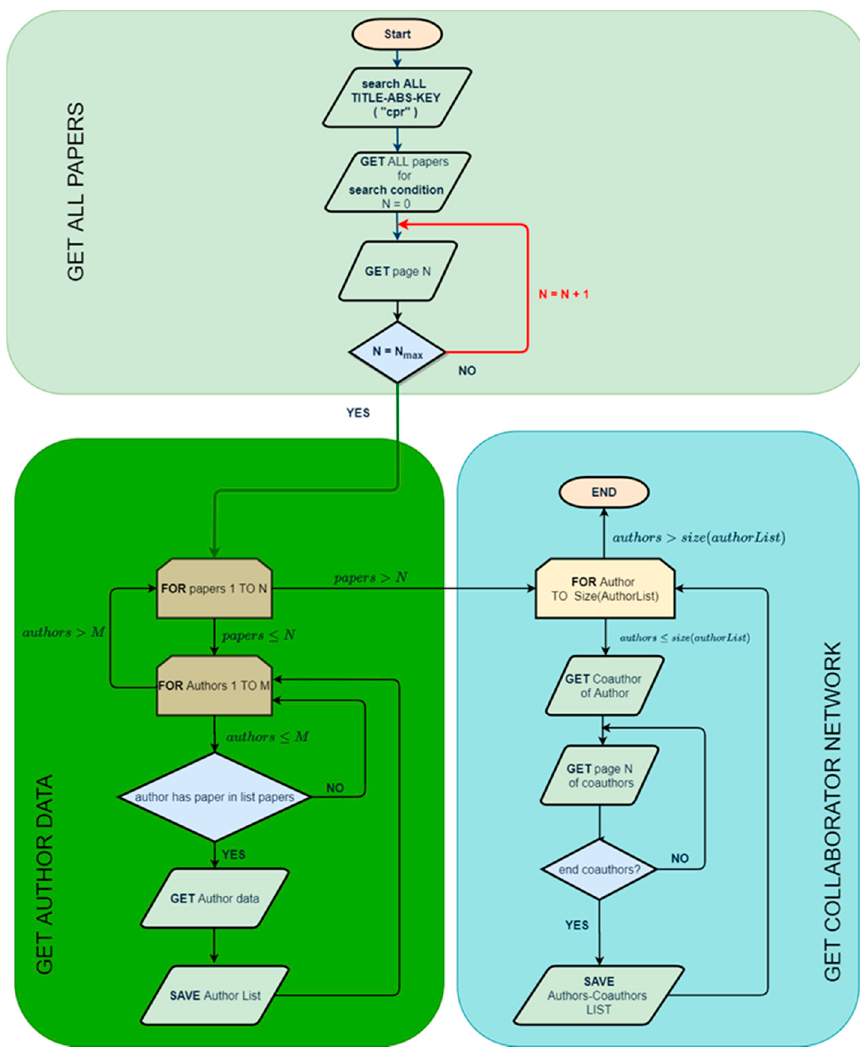
Figure 1. Data analysis procedure.